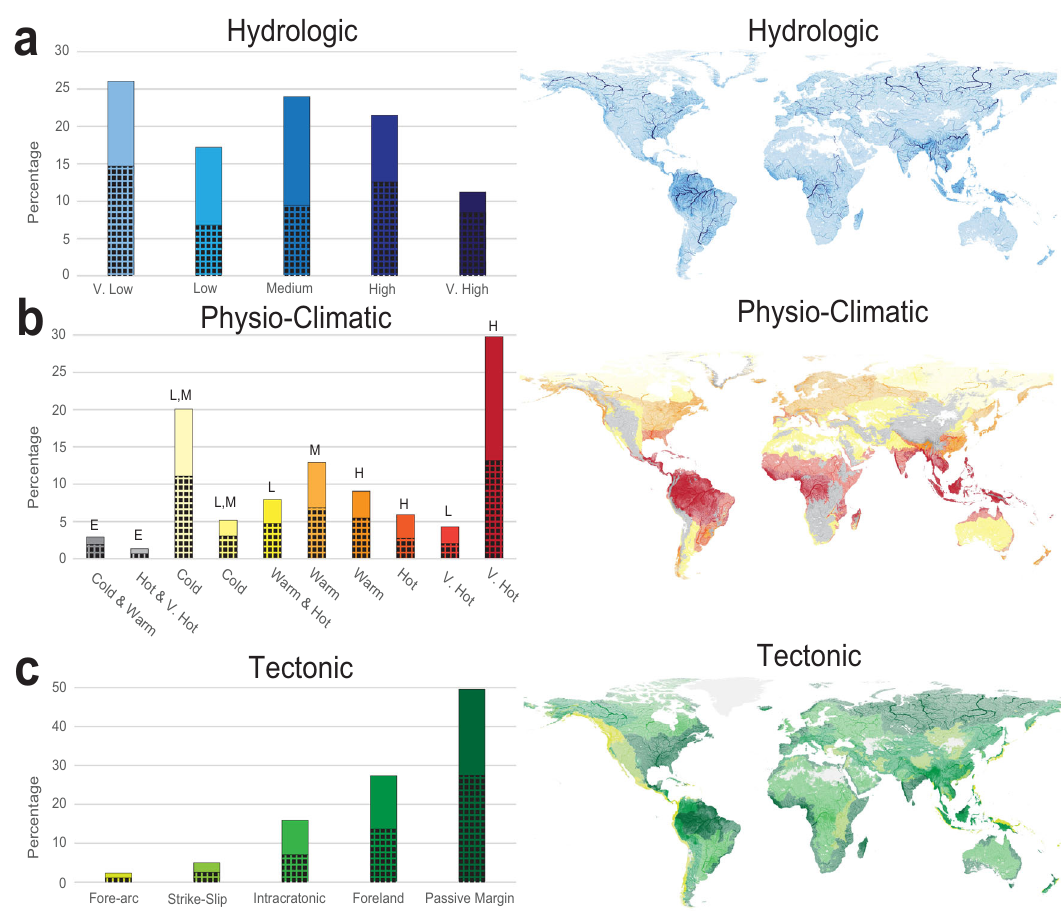
Fig.5|Globalrivermorphologydistributionandcontrols. Thehydrological( a ), physio-climatic ( b ) and tectonic ( c ) distribution and controls on rivers as a per- centage of river surface area visualized based on river reaches 2 . The shaded region of each column shows the proportion of the total surface area of river channels de fi ned as multi-threaded. Long-term averaged monthly river discharge isde fi nedbyOuelletDallaireetal. 2 ,asverylow(0.1 – 10m 3 s − 1 ),low(10 – 100m 3 s − 1